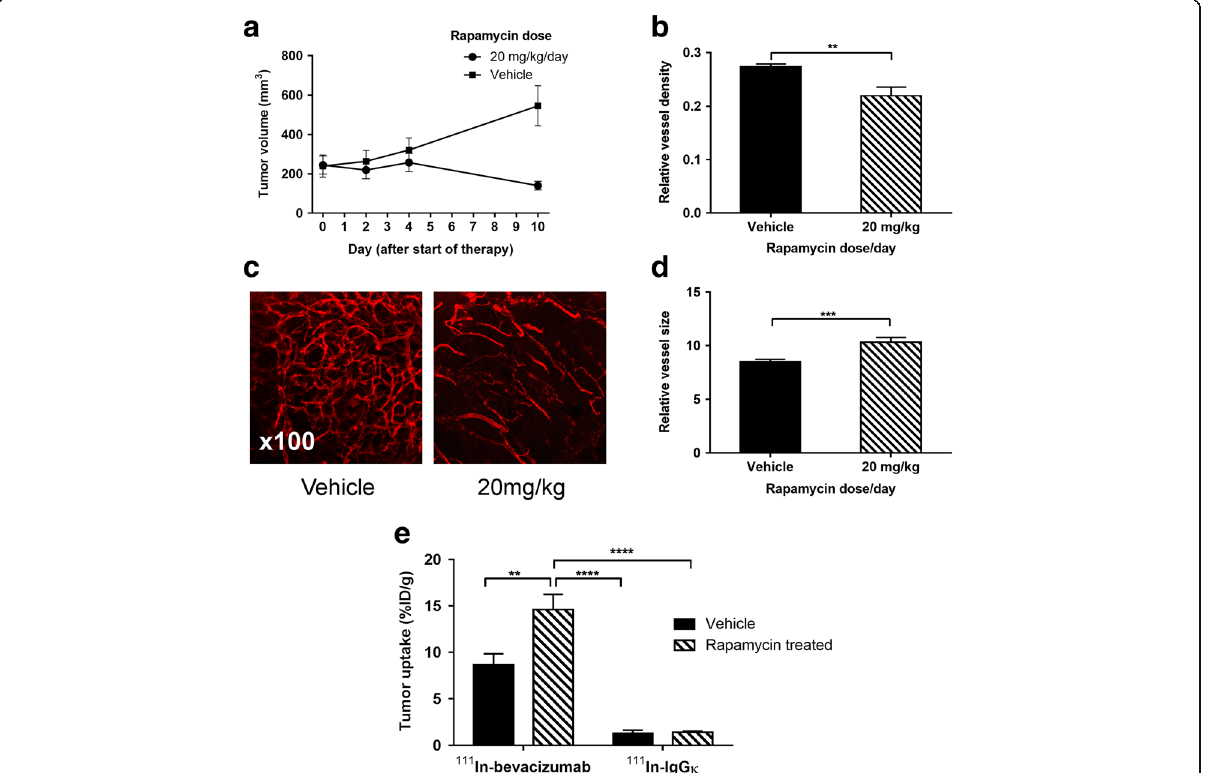
Fig. 5 The effect of rapamycin on FaDu xenografts. a Changes in tumour volume with rapamycin therapy. On day 10, tumour volumes are significantly different ( P =0.0004). b Select images of CD31 confocal microscopy of tumours from mice treated with rapamycin. c Changes in relative mean vessel size with rapamycin therapy. d Changes of relative mean vessel density of rapamycin. e Uptake changes of 111 In-bevacizumab and 111 In-IgG κ in FaDu xenografts treated with rapamycin (20 mg/kg). The control groups were treated with vehicle injections. Data are presented as mean±SEM, ** P <0.01, *** P <0.001, **** P <0.0001, n =6 –